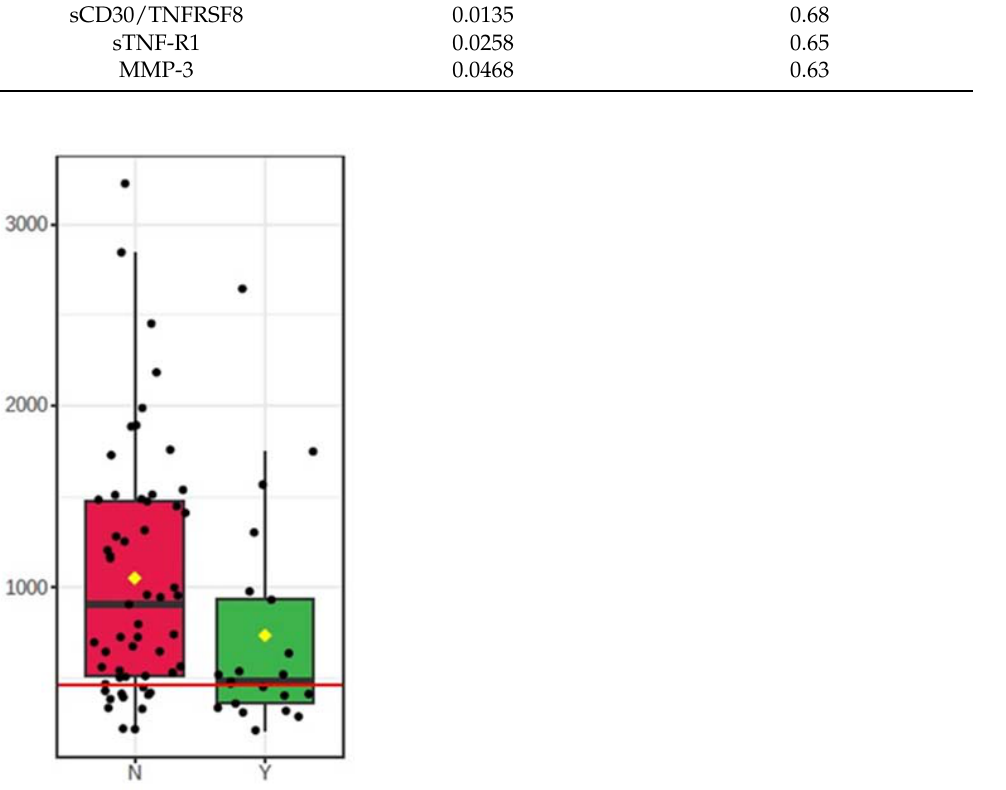
Figure 2. Univariate receiver operating characteristic (ROC) curve representing correlation between serum concentrations of MMP ‐ 3, sCD30/TNFRSF8, and sTNF ‐ R1 in allergy patients and control group. (sTNF ‐ R1 sensitivity: 81%, specificity 47.3%; sCD30/TNFRSF8 sensitivity: 66.67%, specificity 70.91%; MMP ‐ 3 sensitivity: 95.24%, specificity 36.36%).